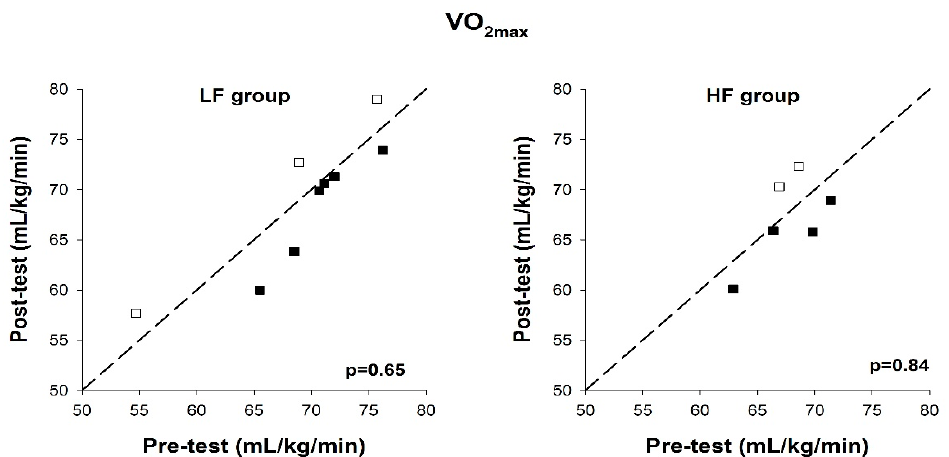
Figure 3. VO 2max at pre-test and post-test, in the low-frequency group (LF group) and high-frequency group (HF group). Reference lines indicate identical values pre- and post-test. Each box represents a test subject. Open boxes indicate an improvement and filled boxes indicate a decline, compared to the pre-test.